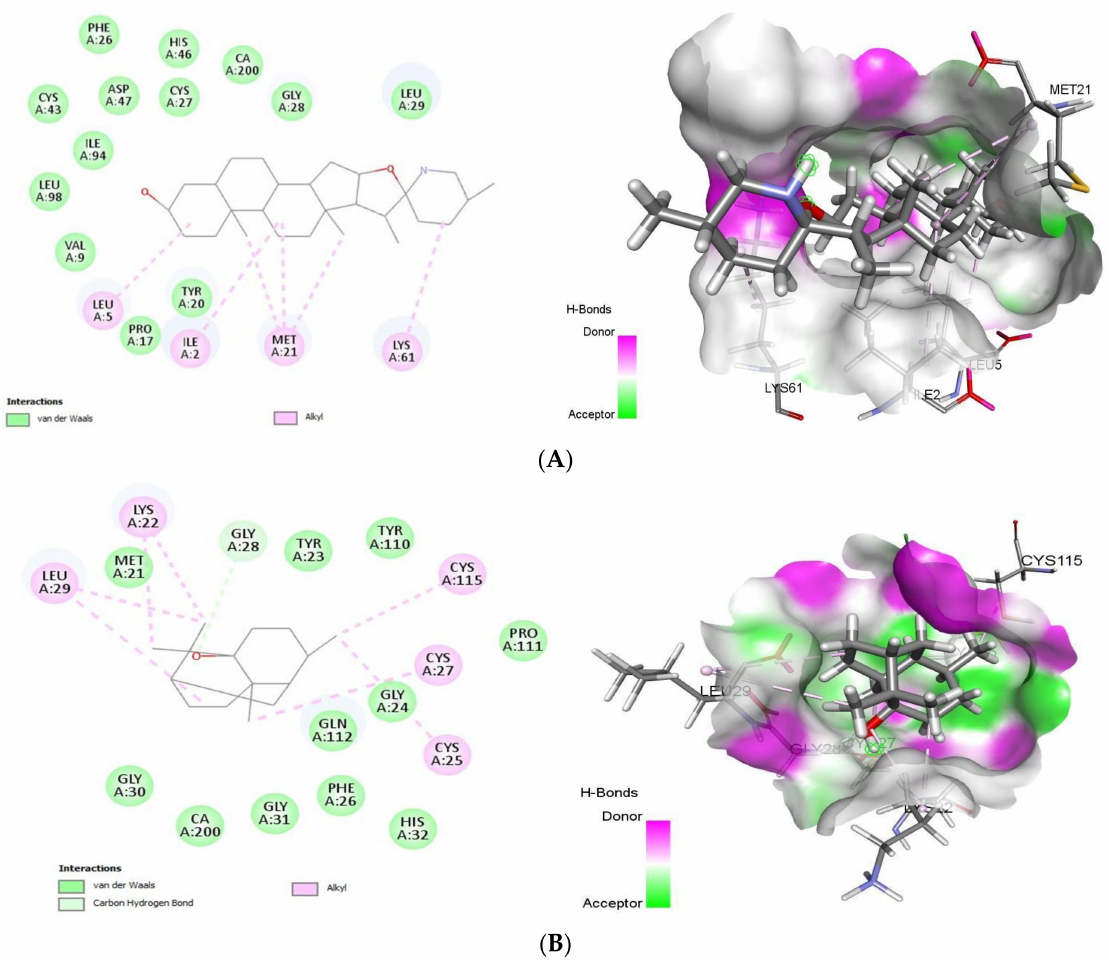
Figure 5. 2D (left) and 3D (right) of tomatidine ( A ) and patchouli alcohol ( B ) with the active site of 4UY1. ( A ): Tomatidine- sPLA2 (PDB ID: 4UY1) (Gold Fitness Score 42.59); Type of binding: van der Waals: Val9, Leu98, Ile94, Cys43, Asp47, Phe26, His46, Cys27, Gly28, Leu29, Tyr20, Pro17; Alkyl: Leu5, Ile2, Met21, Lys61. ( B ): Patchouli alcohol-sPLA2 (PDB ID: 4UY1) (Gold Fitness Score 38.28) Type of binding: van der Waals: Met21, Tyr23, Tyr110, Pro111, Gly24, Gln112, Phe26, His32, Gly31, CA200, Gly30; C-H bond: Gly28; Alkyl: Leu29, Lys22, Cys115, Cys27,